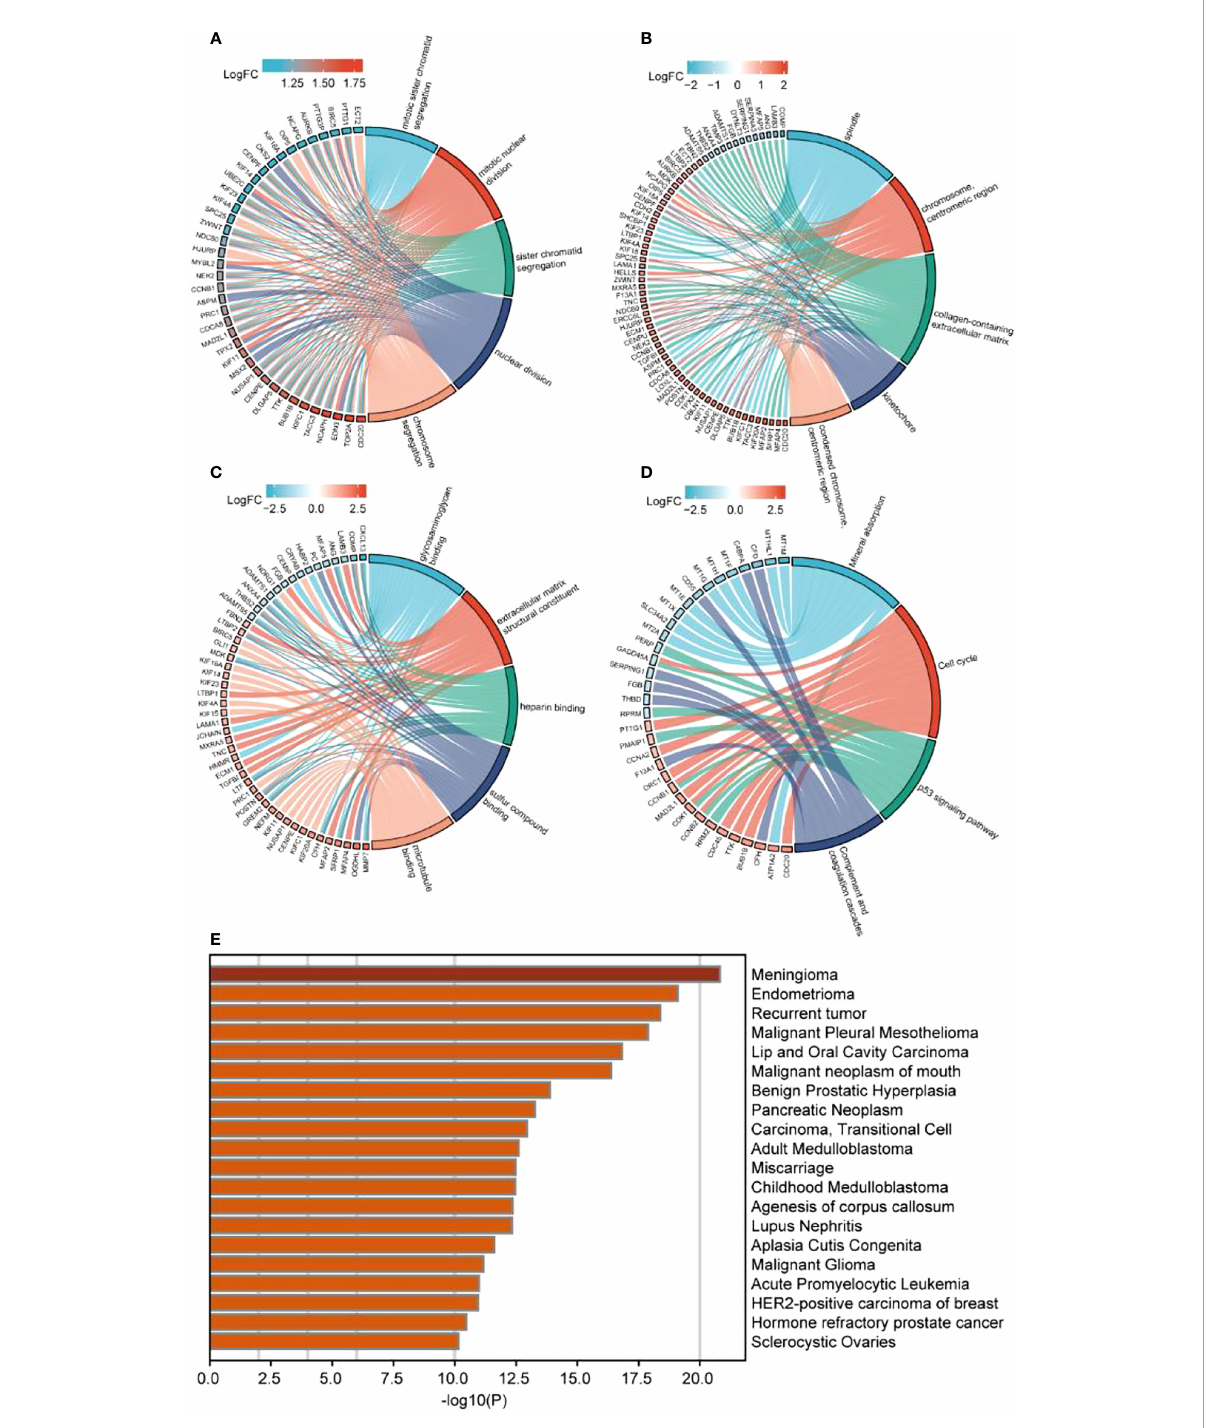
FIGURE 2 Enrichment analysis of differentially expressed immune genes. (A – C) GO enrichment analysis, including (A) BP, (B) CC, (C) MF; (D) KEGG enrichment analysis; (E) Disgenet database disease enrichment